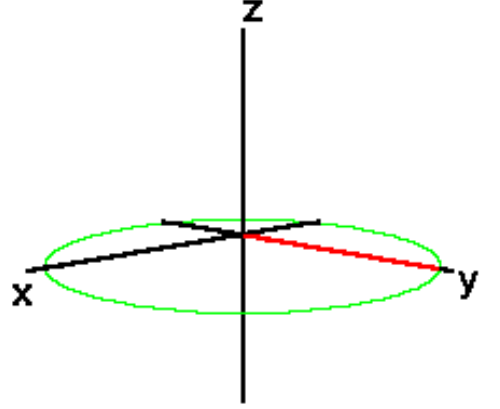
Figure 2. Precession of a magnetization vector in the xy-plane as portrayed in Chapter 3 of The Basics of NMR , © 1997 J.P. Hornak